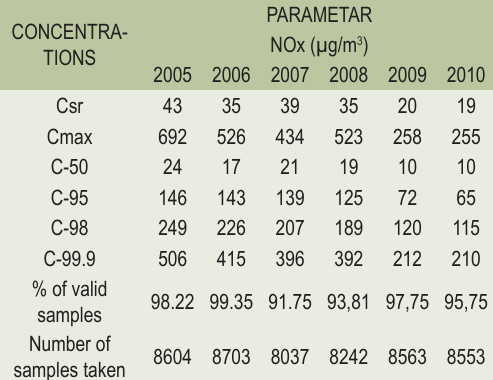
TABLE 5. Statistical overview of the concentration of total nitrogen oxides NOx (hourly samples) Sarajevo-automatic station